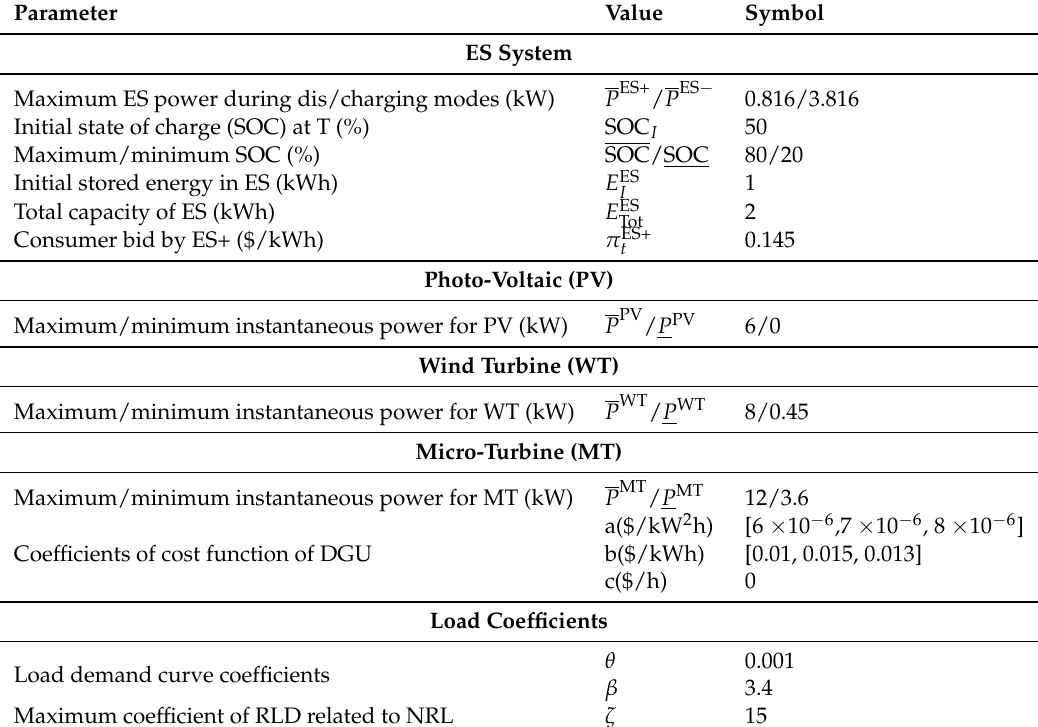
Table A2. Rated profile of distributed energy resources